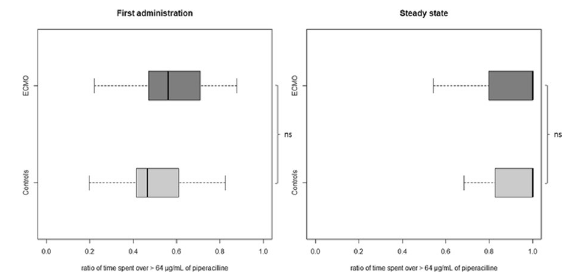
Fig. 1 Ratio of the time between two piperacilline infusion spent above 64 µg/mL during the first administration or at steady state in ECMO patients and in control